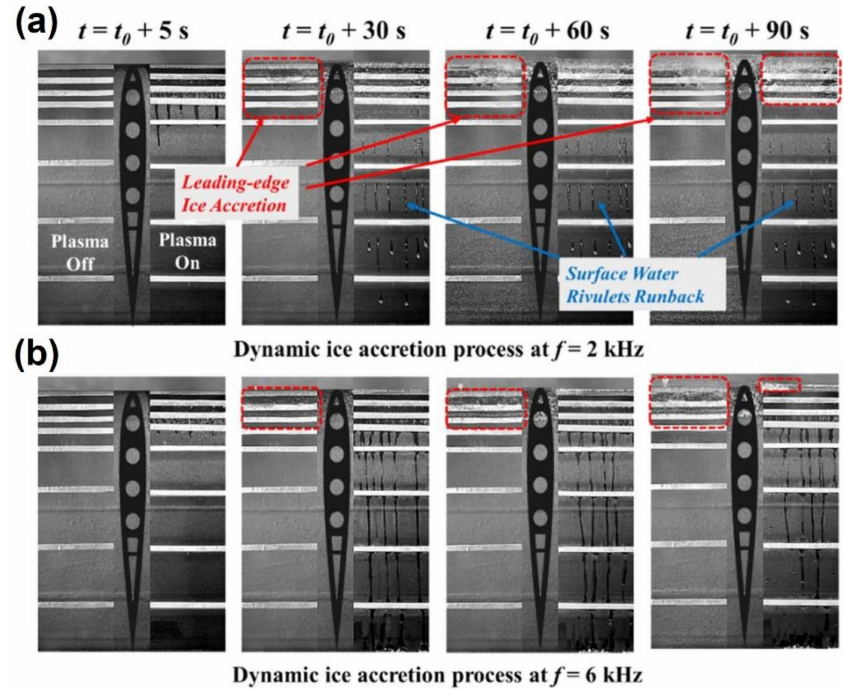
Figure 19. Time-evolution of the dynamic ice accretion experiments over the airfoil surface with the NS-DBD plasma actuator being operated at ( a ) 2 kHz and ( b ) 6 kHz (adapted from Liu et al. [182] with the permission of IOP Publishing).